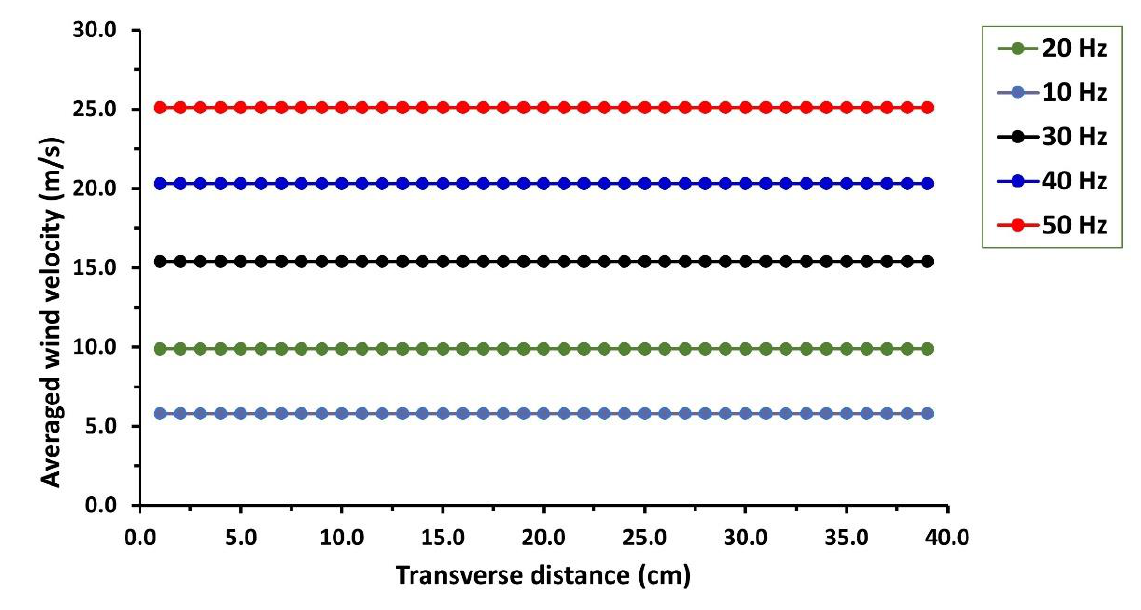
Figure 9. The measured mean velocity at the midplane in the transverse direction between the two side walls of the test section.